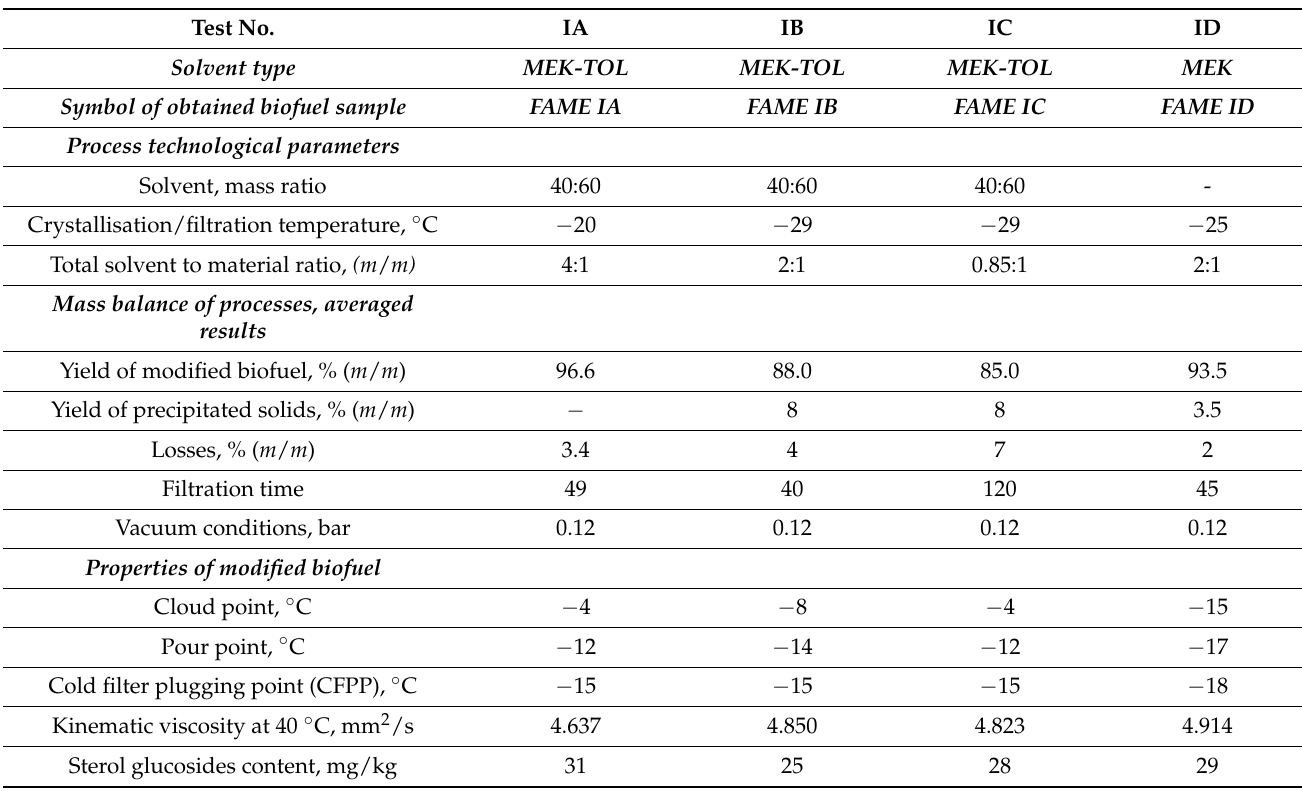
Table 2. Technological parameters and the mass balance of carried out tests, and properties of modified biofuels, when the FAME I was used as a raw material.